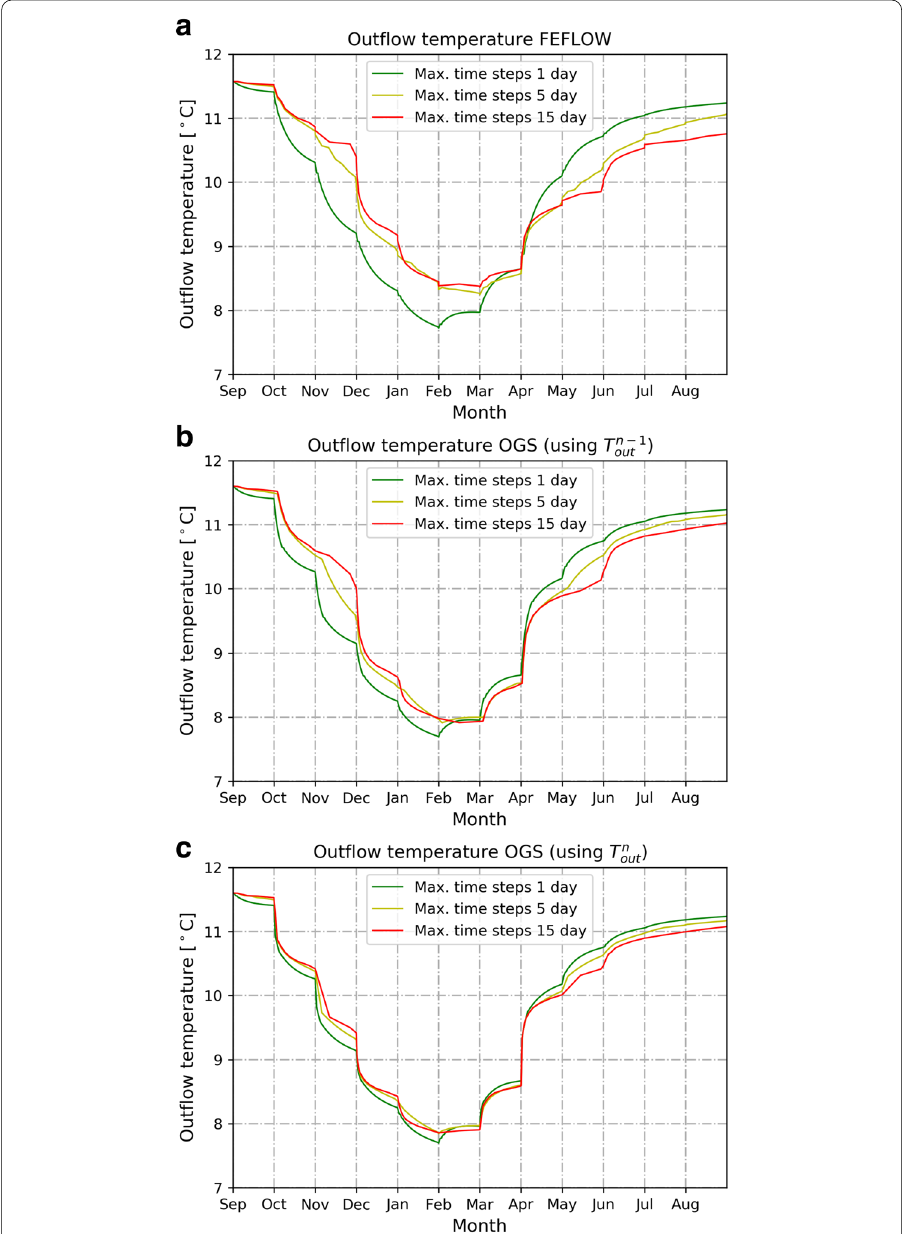
Fig. 8 Outflow temperature comparison for 1st year of operation for a FEFLOW b OGS using the last time step and c